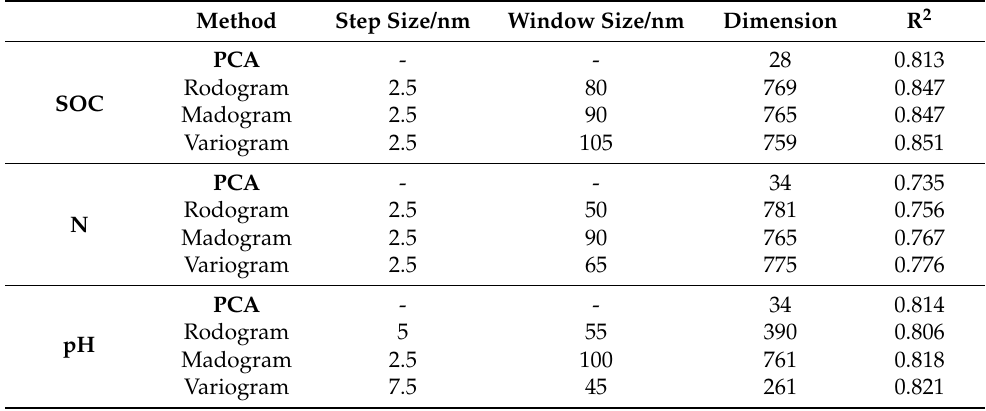
Table 2. Best Performance step–window pairs for soil properties estimation using fractal-based feature extraction and comparison with PCA. R 2 : coefficient of determination.